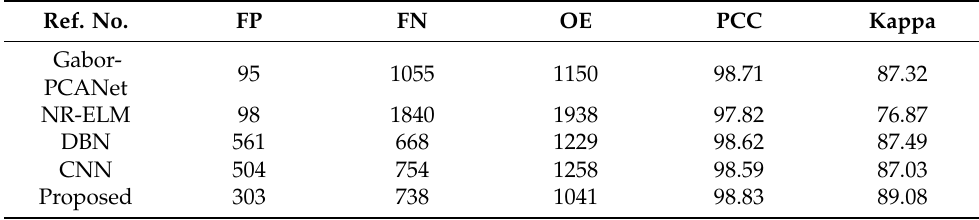
Figure 19. Change detection results on the Farmland C dataset. ( a ) Ground truth. ( b ) Result by Gabor-PCANet. ( c ) Result by NR-ELM. ( d ) Result by DBN. ( e ) Result by CNN. ( f ) Result by our proposed method. Table 6. Change detection results of the Farmland C dataset.